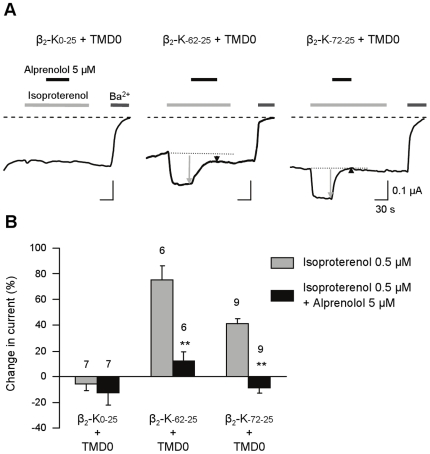
Effect of a β-adrenergic antagonist on β2 ICCRs.(A) TEVC recordings showing antagonist effect of 5 µM alprenolol during addition of 0.5 µM isoproterenol on β2-K0–25, β2-K-62-25 and β2-K-72-25. (B) Change in whole-cell currents evoked by isoproterenol before and after addition of 5 µM alprenolol. **P<0.00075 indicates a significant inhibition induced by alprenolol.